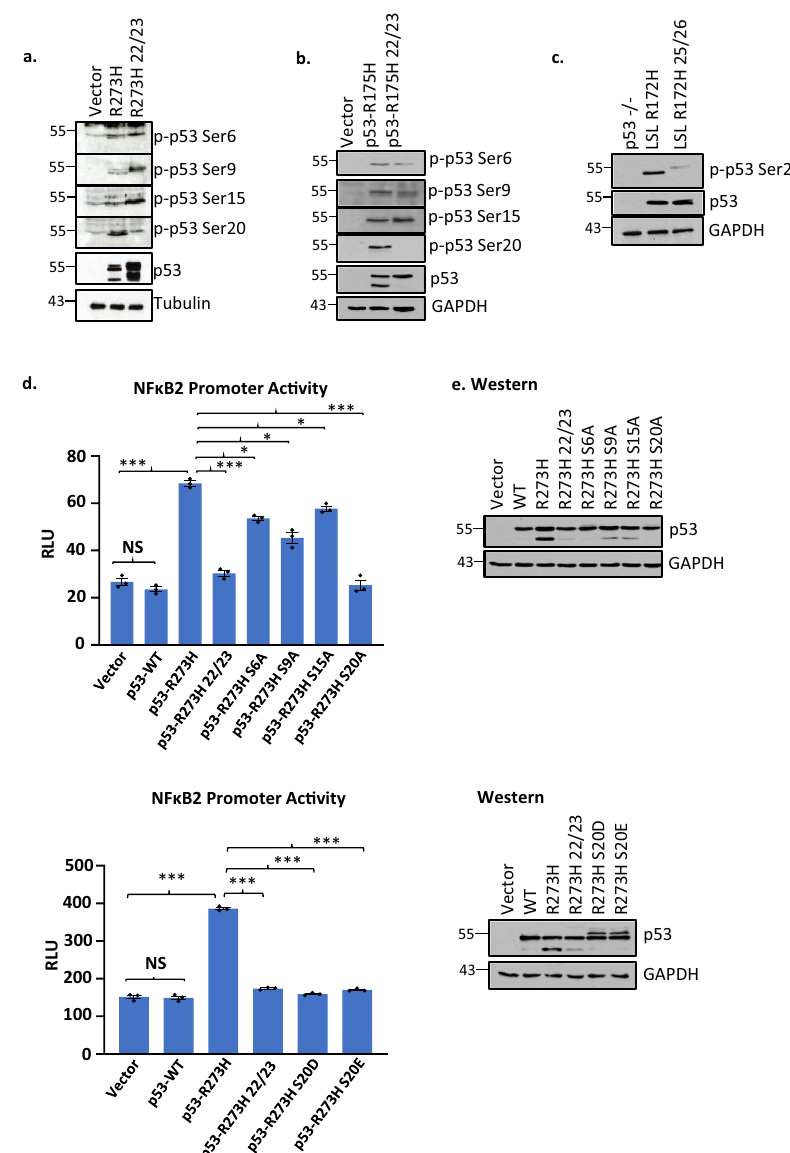
Fig. 6 TAD mutations affect the state of phosphorylation of mutant p53. Western blot analysis of equal amounts of extracts from a H1299 cells expressing p53-R273H, -L22Q/W23S/R273H, and vector control; b H1299 cells expressing p53-R175H, -L22Q/W23S/R175H, and vector control; and c murine lung cells expressing p53-R172H, -L22Q/W23S/R172H, and p53 – / – control were developed with antibodies against different phosphorylation sites on p53. The data presented show that phosphorylation at amino acid position 20 went down signi fi cantly. d Transactivation assays of mutant p53 and its derivatives by Ala substitution mutations at positions of phosphorylation using a mutant p53 inducible gene promoter. Transient transcriptional assays were carried out in H1299 cells after transfection of NF- κ B2-luc and indicated expression plasmid or empty vector. Cells were harvested after 24 h of transfection. Fire fl y luciferase readings were plotted as relative light units (RLU). Data are presented as the mean ± SEM ( n = 3, performed twice). A two- sided Student ’ s t -test was performed. Ser20Ala substitution reduced the transactivation ability the greatest. Substitution of S20 to Glu or Asp did not regain transactivation ability either. e Western blot analysis showing level of different p53 mutants after transfection. * p -value < 0.05, ** p -value < 0.01, and *** p -value < 0.001. NS no statistically signi fi cant difference from